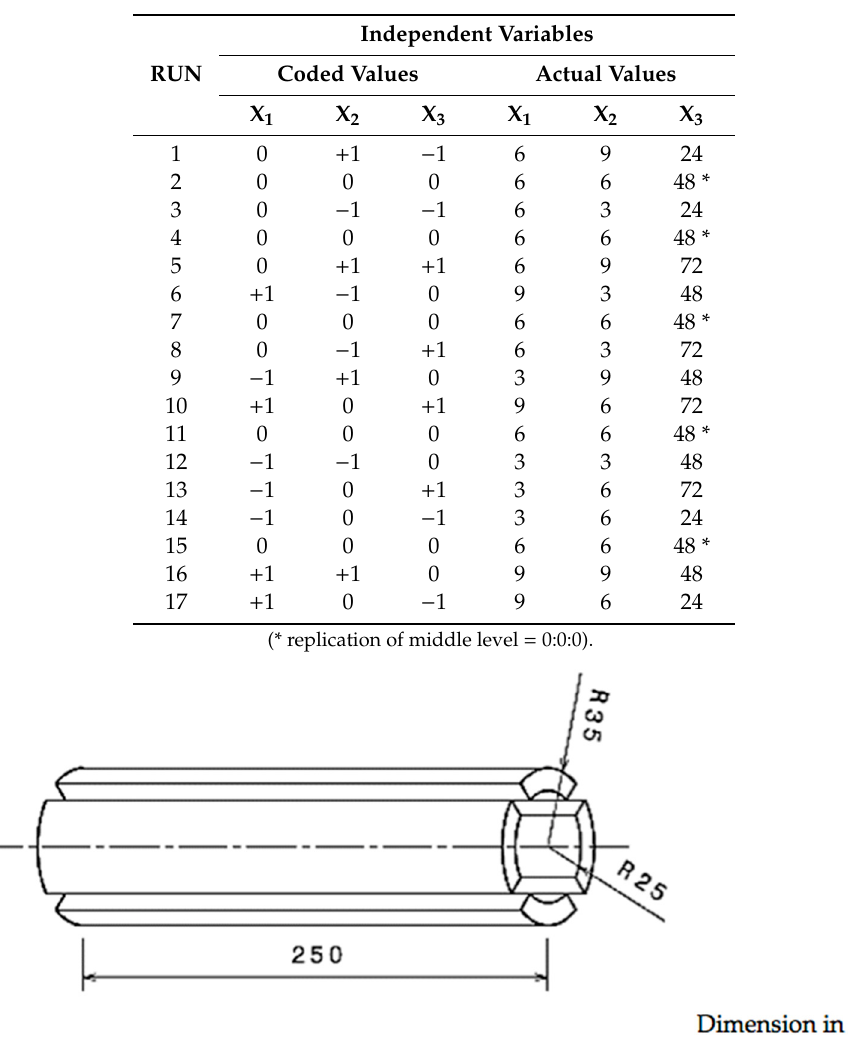
Table 2. Experimental trials derived from Design-Expert Software.